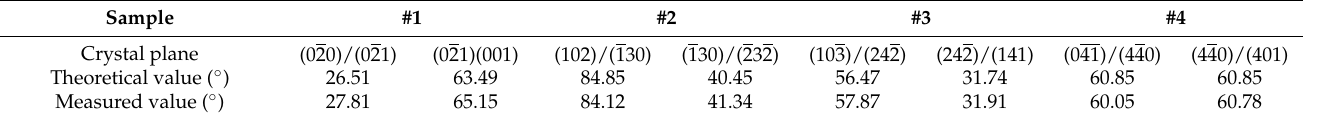
Table 4. Included angle of crystal planes of dispersed nanoscale phases in the matrix of FeCrAl ODS steels.